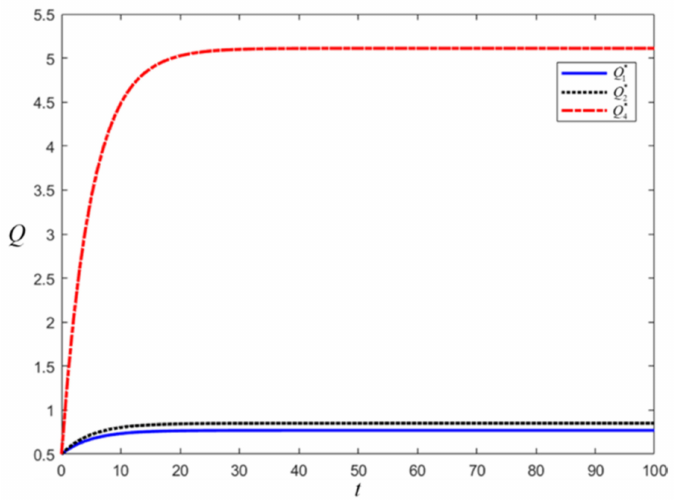
Figure 2. Comparison of optimal PG for three game